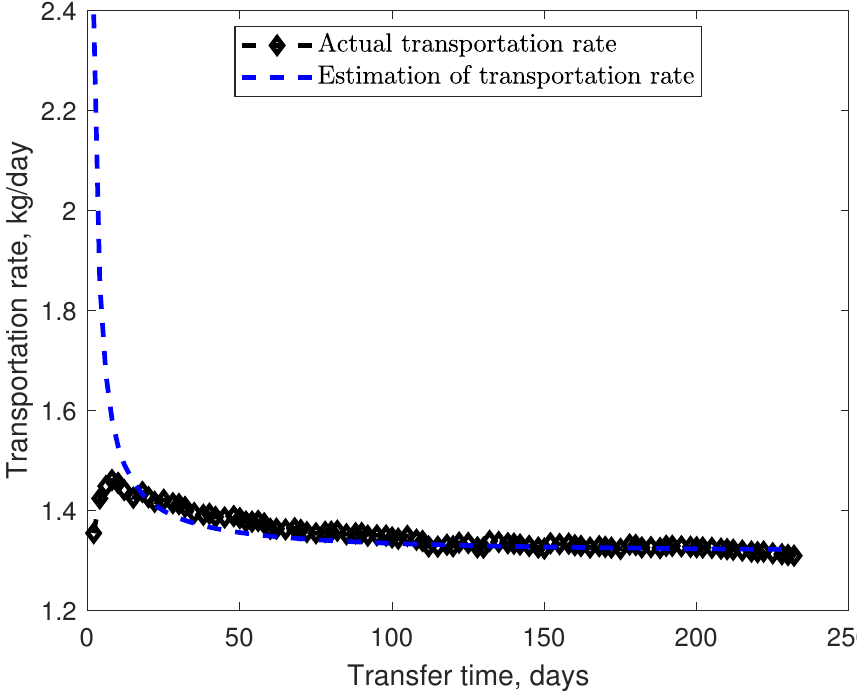
Figure 13. Prediction error of fuel consumption and magnitude of impulsive burn when T max = 100 mN and I sp = 3500 s.